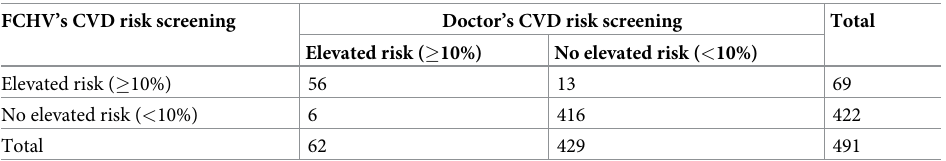
Note: The cardiovascular risk level is treated as a dichotomous variable here for calculating specificity and sensitivity of FCHV screening test. Cardiovascular risk higher than 10% is regarded as elevated cardiovascular risk in following 10 years; cardiovascular risk lower than 10% is regarded as no elevated cardiovascular risk. Doctor’s screening result is treated as gold standard.